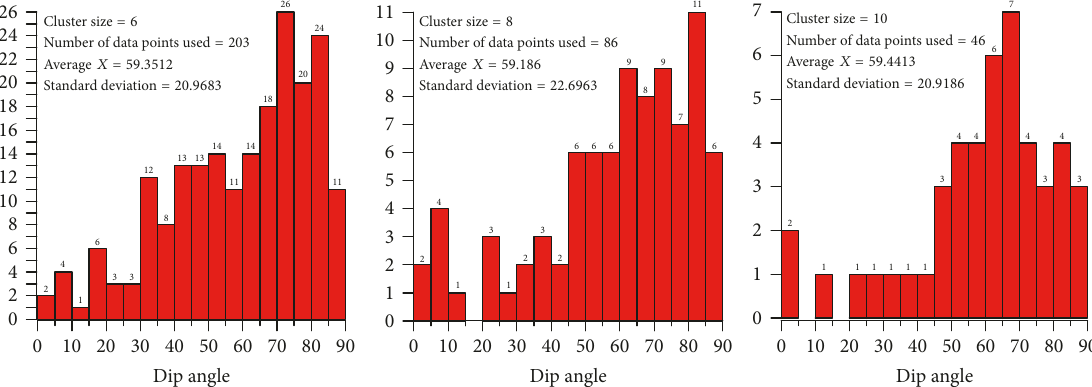
Figure 32: Histograms of the Frac-Digger sensitivity of the estimated dip angles of dikes to the cluster size (or the number of events in cluster 𝑁 ).